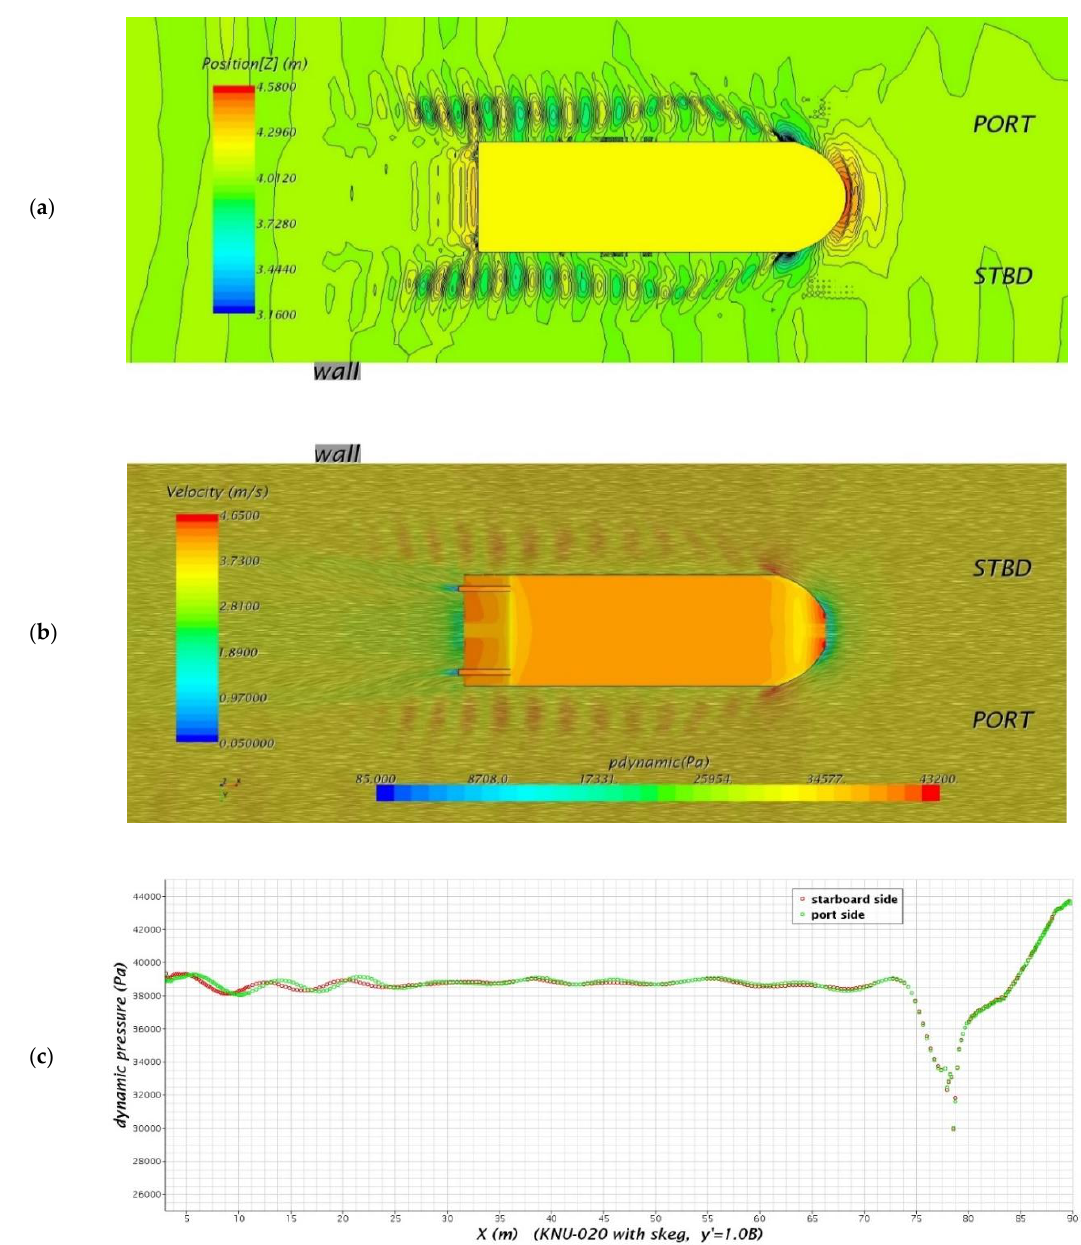
Figure 8. Simulation results for KNU-020 at y′ = 1.0 B : ( a ) wave pattern; ( b ) velocity field with line integral convolution and hydrodynamic pressure distribution on the bottom; and ( c ) hydrodynamic pressure on the starboard and port side.